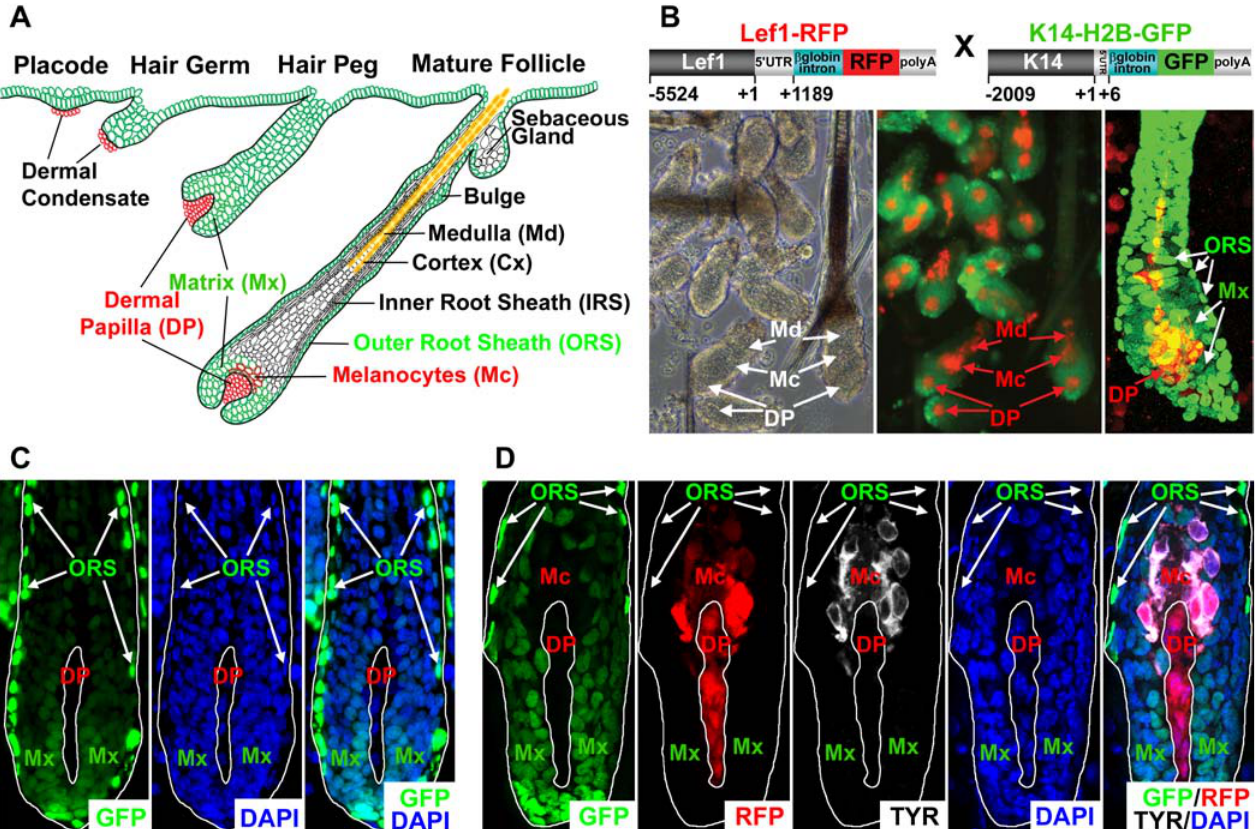
Figure 1. Hair Follicle Morphogenesis and Differential Expression of Lef1-RFP and K14-H2BGFP in All Cells of the Mature Follicle (A) Schematic depicts follicle morphogenesis, which begins in waves in mouse backskin at approximately embryonic day 15 ( ; E15) and is complete at approximately postnatal day 4 ( ; P4). (B) Transgene constructs and mice. The transgenes used for injection are shown in the stick diagrams. Nucleotide residues encompassing the gene fragments cloned are noted ( þ 1 is the transcription initiation site). For each transgene, three transgenic lines were engineered; all were phenotypically normal. Data shown are from P4 backskin follicles of mice harboring both transgenes. Left and middle images are phase contrast and epifluorescence images, respectively, of hair follicles after dispase and collagenase treatment. Right image shows 3D reconstruction of a confocal Z-stack of a follicle showing that most of the RFP resides in the center of the follicle bulb. DP, dermal papilla; Mc, melanocytes; Md, medulla; Mx, matrix; ORS, outer root sheath. (C) Section of K14-H2BGFP follicle, which at P4 (shown) is fully mature. Images shown are DAPI and epifluorescence channels, separately, and merged. Note the approximately 3-fold higher levels of GFP in ORS nuclei (arrows) compared to Mx nuclei and its progeny. White lines demarcate the mesenchymal–epithelial boundaries, which are separated by a basement membrane of ECM. (D) Four-color confocal image of a section of a K14-H2BGFP and Lef1-RFP double transgenic follicle at P4. In addition to H2BGFP (green) and RFP (red) epifluorescence, the follicle was labeled with DAPI (blue) and Abs against tyrosinase (secondary Abs are against Cy5 in the far-red and white was used as a pseudocolor). Note that the anti-tyrosinase antibody labels the RFP-positive Mc and demarcates them from the RFP-positive, anti- tyrosinase negative DP. Note also that Mc are located on the epithelial side of the basement membrane, denoted by the white lines. DOI: 10.1371/journal.pbio.0030331.g001